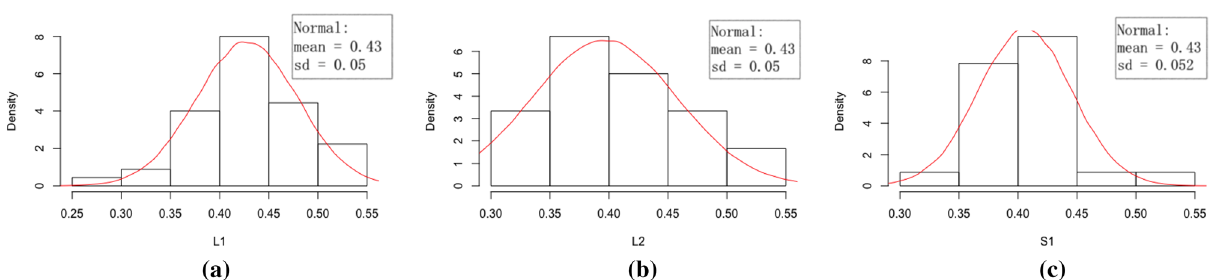
Figure 8. Pore network; ( a ) probability distribution of degree distribution for L1, ( b ) probability distribution of degree distribution for L2, (c) probability distribution of degree distribution for